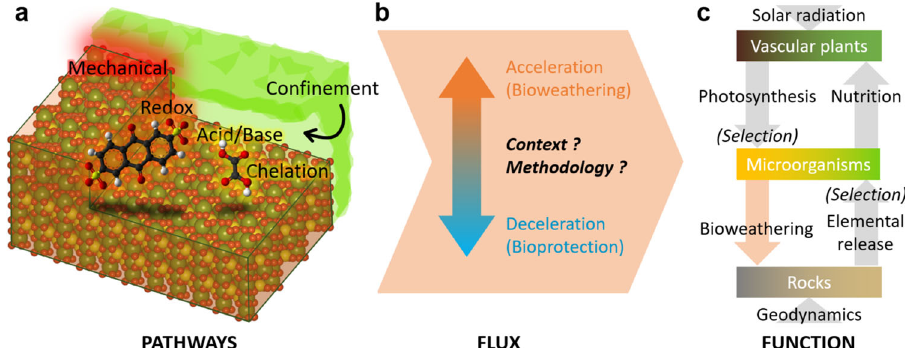
Fig. 2 The impact of living organisms on mineral weathering. a Main pathways by which living organisms impact mineral-weathering rates. These pathways involve either direct contact with the mineral (mechanical processes and redox through membrane-bound enzymes for instance), close proximity (con fi nement of the fl uid – mineral interface achieved by the secretion at the direct vicinity of the mineral of a porous matrix of extracellular polymeric substances (EPS)), or mediated through the fl uid by the secretion of chemical compounds (acids, bases, redox-active molecules, or chelators). Con fi ned space, enclosed between the mineral surface and the microbial cell or EPS (represented indiscriminately by organic matter in light green, panel a ), can enable the control of the chemical activities of solutes independently form the bulk fl uid. b These pathways have been shown to accelerate mineral weathering, even though some of them may similarly lead to lower rates (by reaching close-to-equilibrium conditions in con fi ned space, or through competition for reactive sites). No consensus has however been reached on this point due to signi fi cant methodological variations or the diversity of contexts considered (see the text). c Bioweathering is part of a larger set of element fl uxes occurring on Earth ecosystems, and there is increasing evidence that BW, mostly driven by microorganisms, supports the development of continental ecosystems by stimulating the release of rock-derived